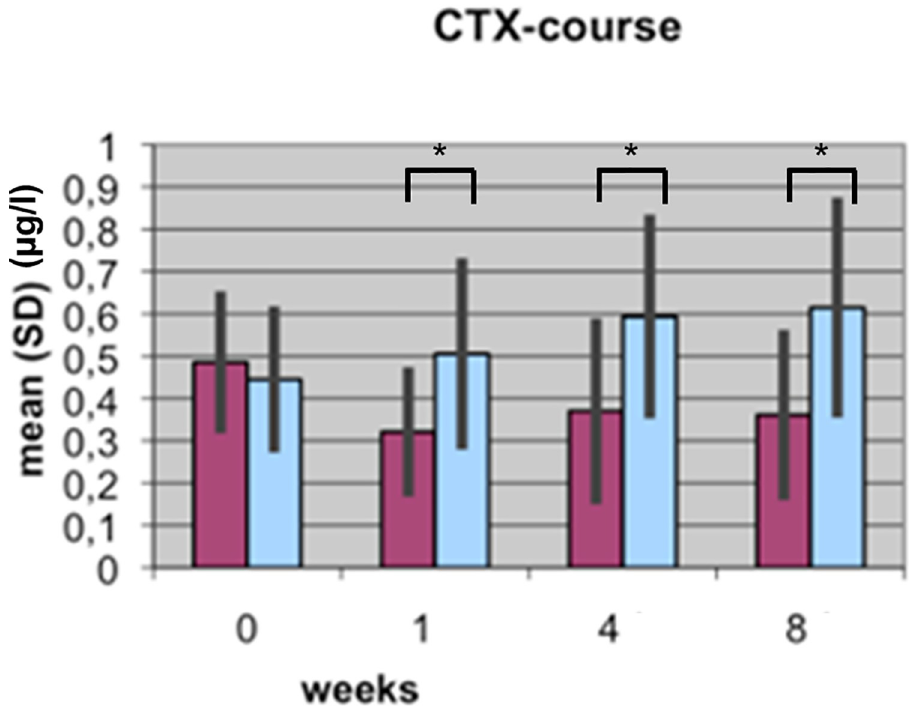
Fig 3. Course of CTX serum concentration ( µ g/l) during fracture healing of eight weeks in low BMD versus normal BMD patients. (Dark bars: low BMD group, light bars: normal BMD group). Statistics were performed using the software SPSS 11.0.0 (IBM Germany, Munich, Germany), Friedman test, Wilcoxon rank test and Mann-Whitney U tests were used. P � 0.05 was considered to be significant, p � 0.01 as very significant, and p � 0.001 as highly significant. Different levels of significance are marked by one to three